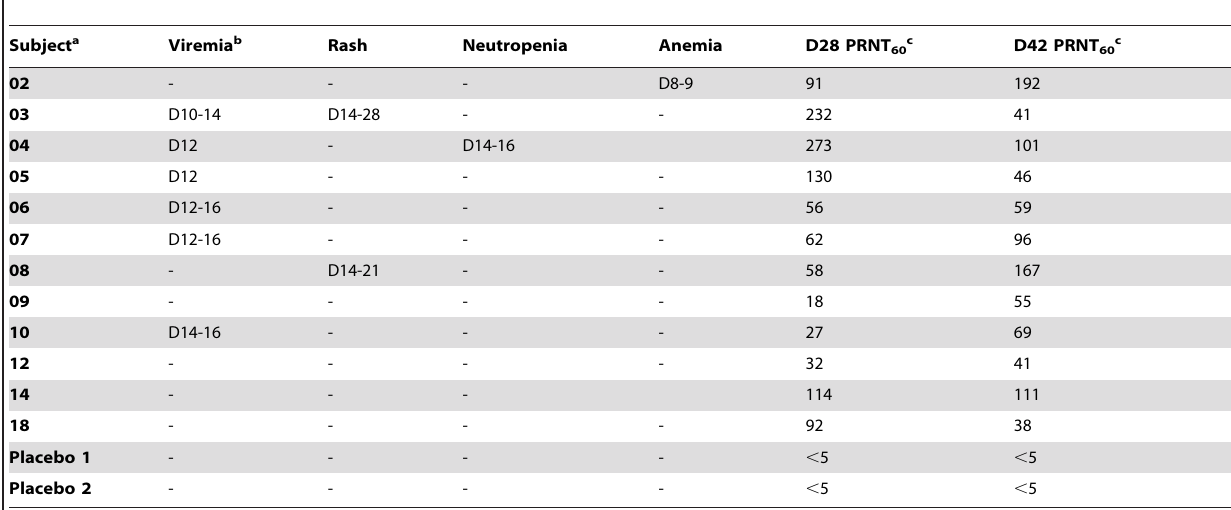
Table 1. DENV-1 vaccinees display a variety of clinical signs, symptoms and immunologic